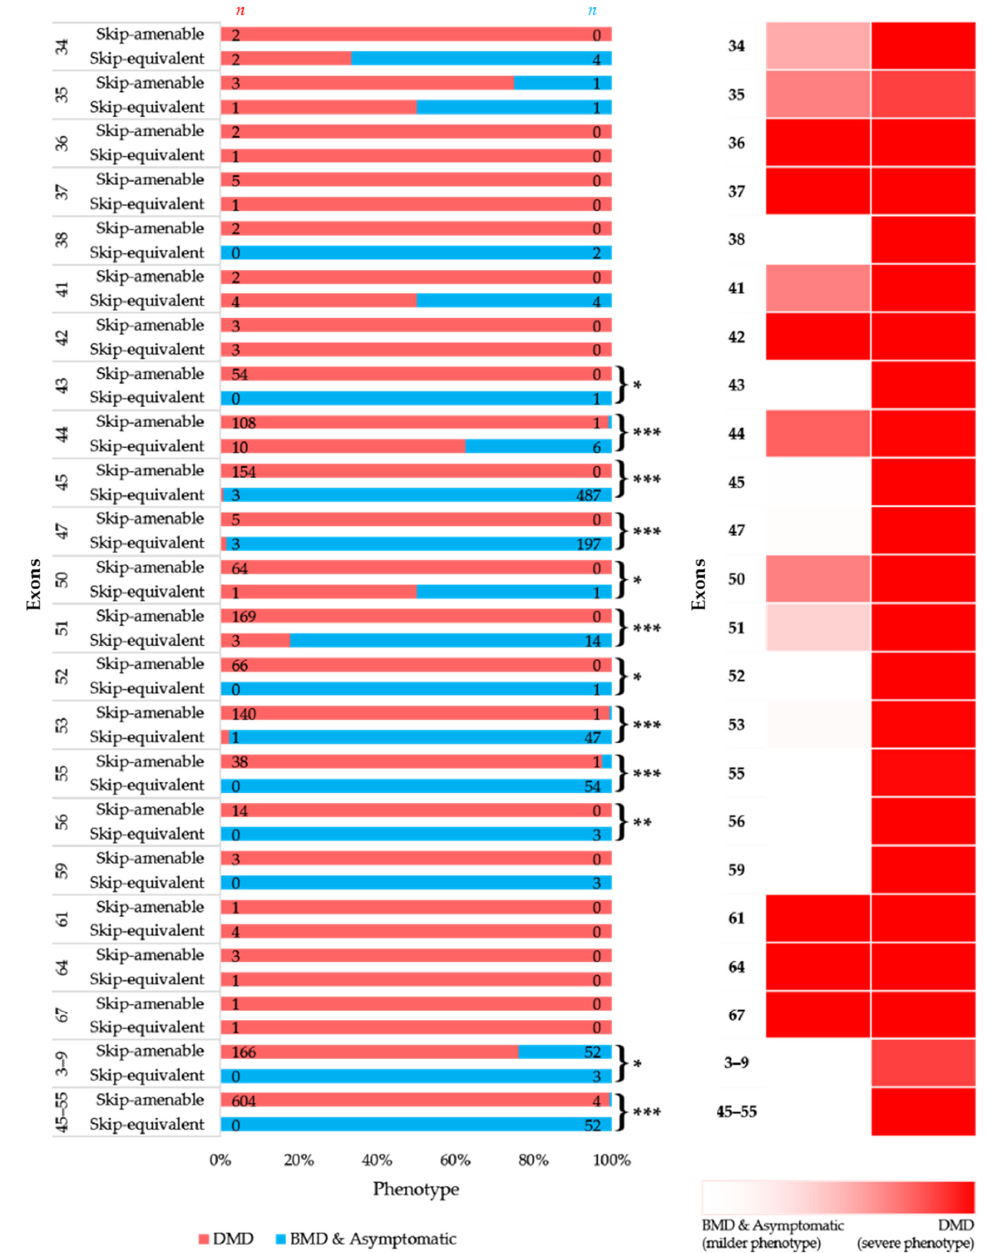
Figure 4. Comparison of clinical phenotypes associated with out-of-frame mutations amenable to exon skipping in UMD-DMD database and in-frame exon skip-equivalent deletions of each exon to simulate the effects of exon-skipping therapies. ( A ) Phenotypic outcomes associated with mutations amenable to exon skipping and exon skip-equivalent in-frame deletions of each exon and their consequent phenotypes. n indicates the number of individuals with DMD (red) and milder (blue; BMD and asymptomatic) phenotypes. Asterisks indicate that exon skip-equivalent in-frame deletions are associated with a significantly milder phenotype compared to corresponding exon skip-amenable out-of-frame mutations. We compared the incidence of DMD associated with exon skip-equivalent (or group of exons, e.g., exons 3–9, and exons 45–55) and mutations amenable to skipping each exon (or group of exons, e.g., exons 3–9, and exons 45–55). The statistical significance was calculated using Fisher’s exact test. ( B ) Heatmap showing the relative severity of the consequence of exon skip-equivalent in-frame deletions and exon skip-amenable mutations. * p < 0.05, ** p < 0.01, *** p < 0.001